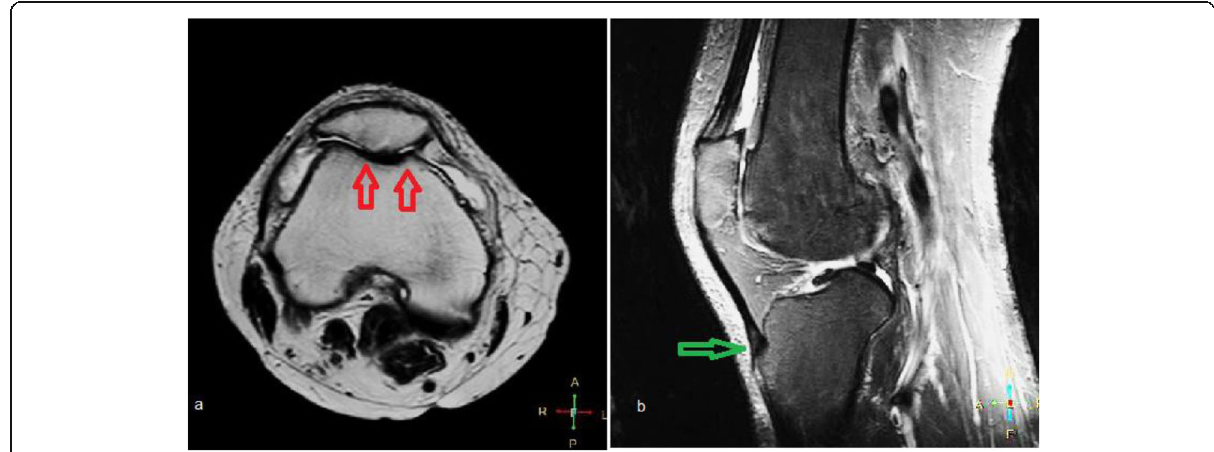
Fig. 5 a, b MRI images for grade IV chondromalacia patella with infrapatellar tendinopath.. a Axial T2-weighted image. b Sagittal PD fat suppression demonstrated diffuse full-thickness articular cartilage loss associated with subtle subchondral bone marrow edema (red open arrows). Note the high signal within the patellar tendon at the tibial tuberosity attachment (green open